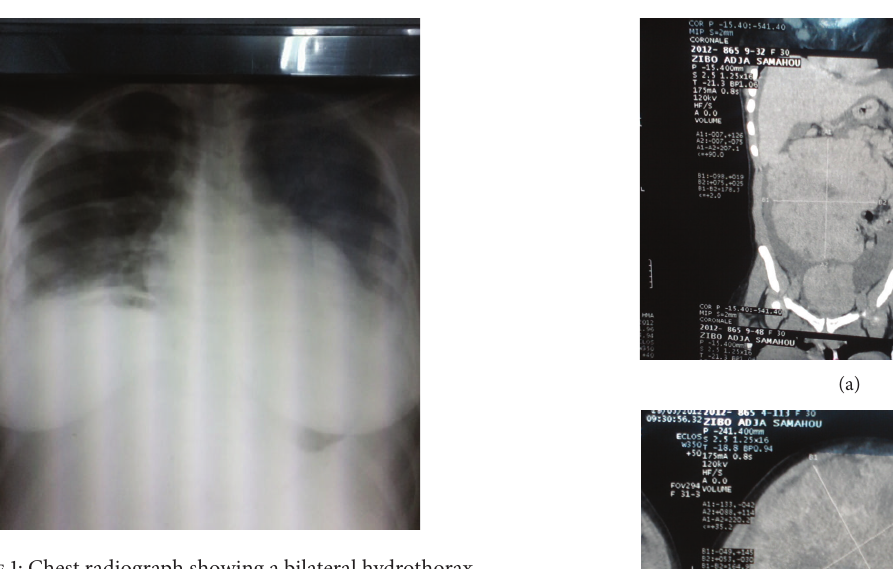
Figure 1: Chest radiograph showing a bilateral hydrothorax.